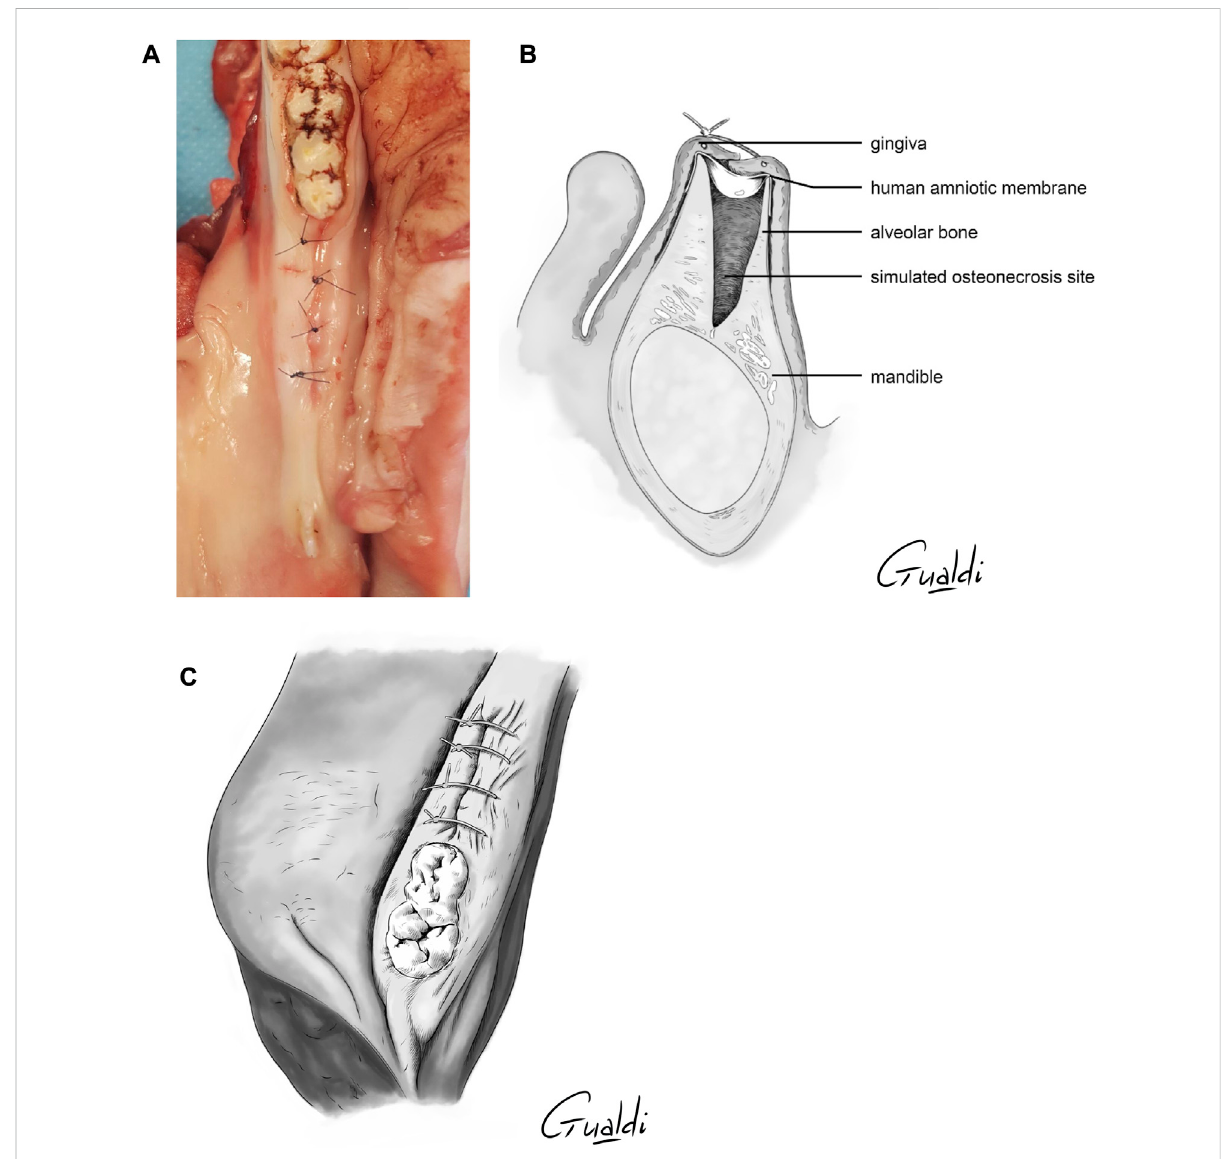
FIGURE 4 hAMimplantationwithcompletecoverage.ThesutureswererealizedabovetheimplantedhAMwhichwasthusnotvisible. (A) Photography; (B) Sagittal section illustration; (C) Upper view